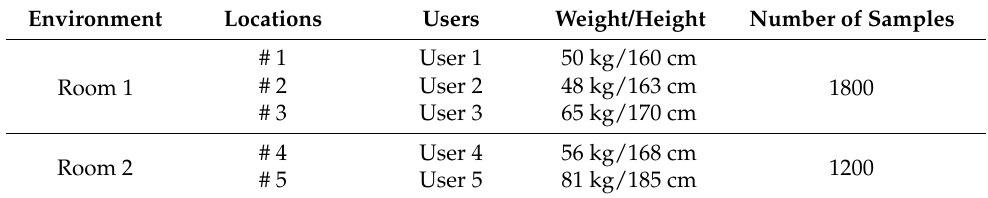
Figure 3. Six common types of gestures: upward, downward, leftward, rightward, circle, and zigzag. Table 1. CSI-Domain Adaptation (CSIDA) data collection summary.